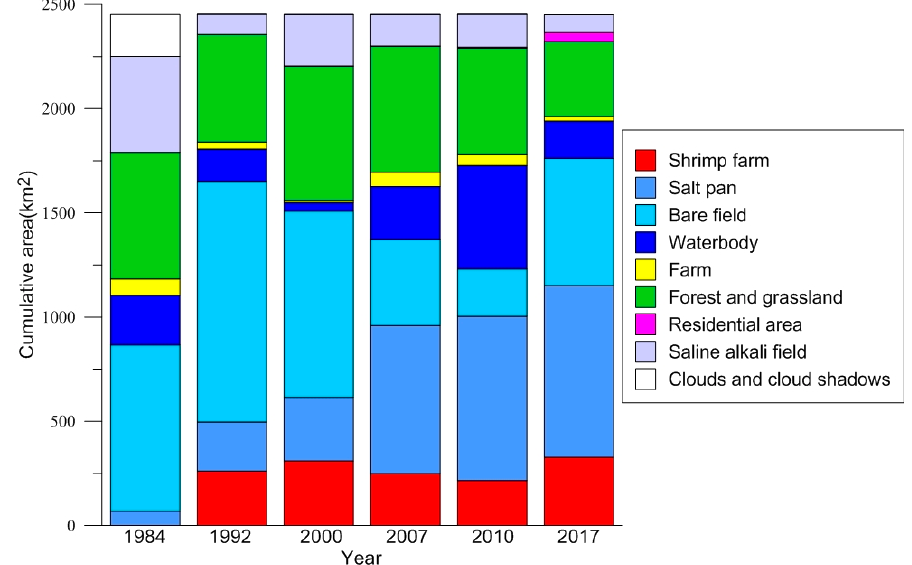
Figure 5. Changes in the area of each land-use type for each classified Landsat image. Table 3. Validation statistics of each land-use map.